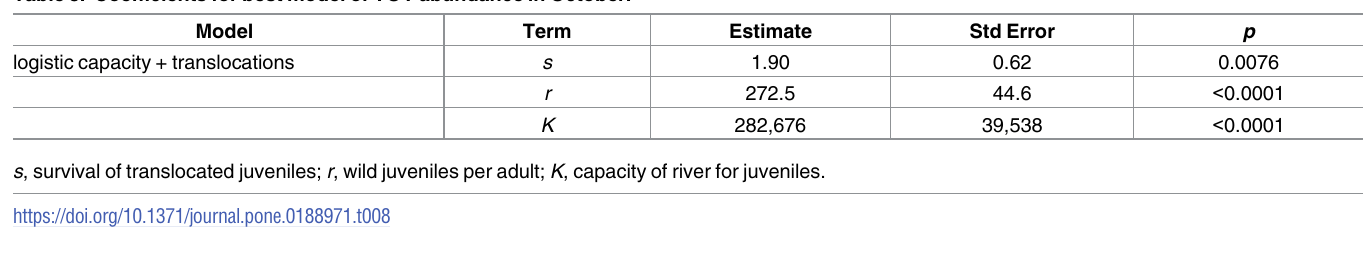
Table 8. Coefficients for best model of YOY abundance in